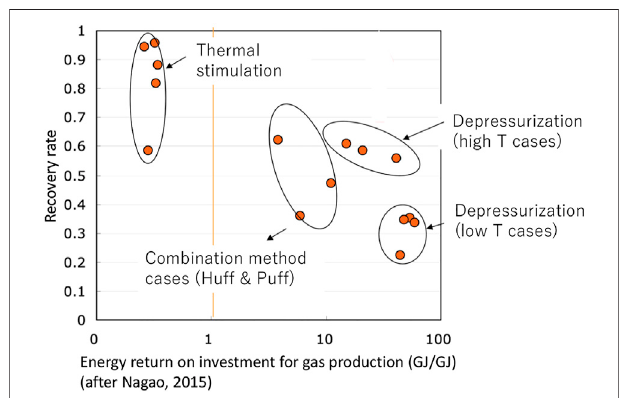
FIGURE 4 | Estimated recovery rate and energy return on investment of each of the production technologies (depressurization, combination method, and thermal stimulation) at three Nankai Trough gas hydrate reservoirs with different temperatures and pressures evaluated by numerical simulations (Kurihara et al., 2008; Nagao, 2015). The recovery rate by the depressurization method was governed by the formation temperature along with permeability of the formations.